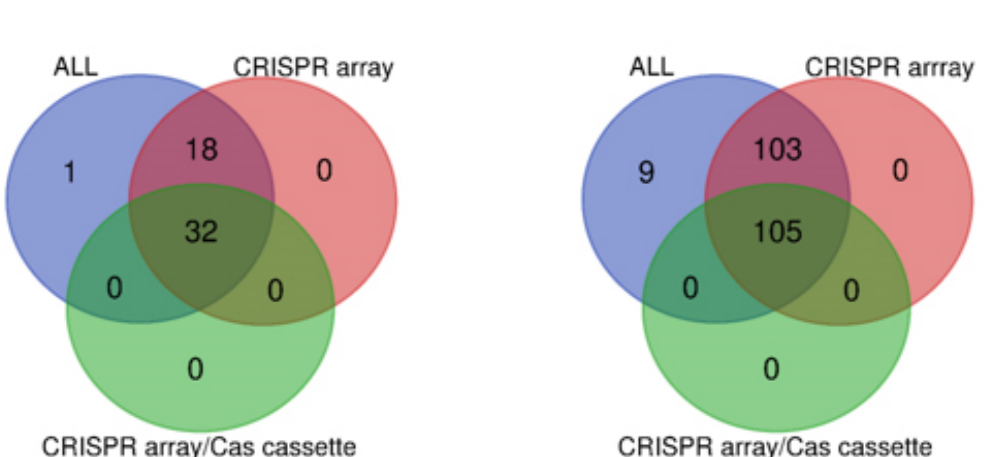
Figure 1. Venn diagrams of CRISPR/Cas element distribution for CriePir P. aeruginosa isolates sequenced by us ( left ) and reference isolates available from Pseudomonas genome DB ( right ).